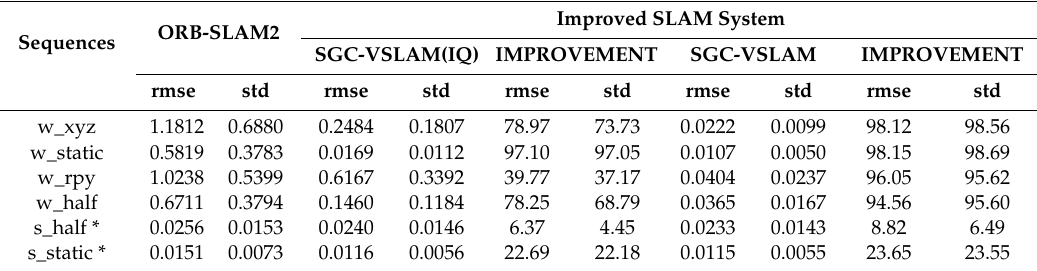
Table 2. Experimental results of the relative displacement trajectory